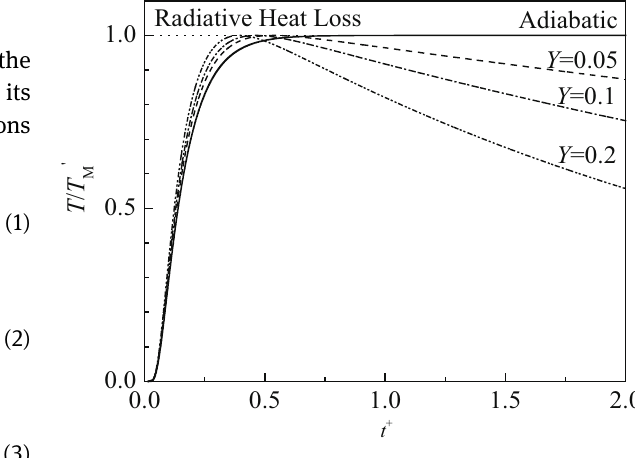
Figure 1: Normalized theoretical temperature - response curves considering radiative heat